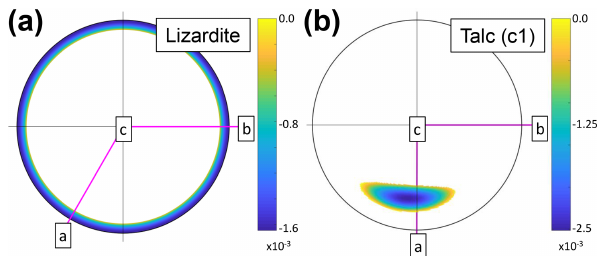
Figure 15. Rock-forming minerals showing negative linear com- pressibility (NLC) in certain directions. Stereograms are all lower- hemisphere equal-area projections and only the directions with NLC are shown coloured in (i.e. other directions show positive val- ues). Crystallographic axes in pink. (a) Lizardite. (b) Talc (c1, tri-